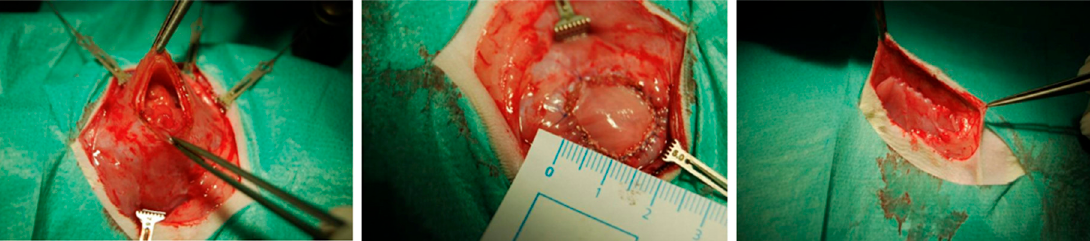
Figure 2. Intraoperative images of the abdominal wall replacement model: Left —Preparation of the abdominal wall defect. Middle —Defect closure with the biocellulose patch. Right —Situs before closure of the subcutaneous tissue.